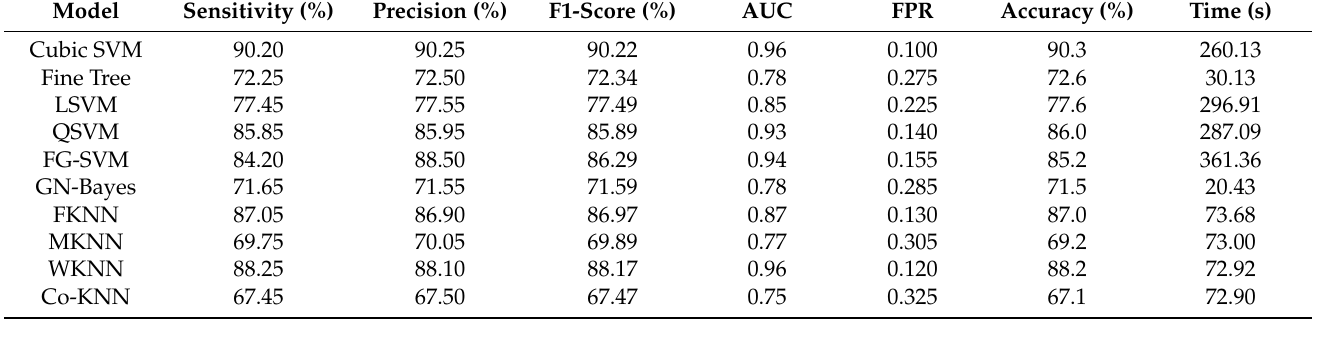
Table 2. Classification results using Fine-tuned MobilenetV2 deep features for CBIS-DDSM.